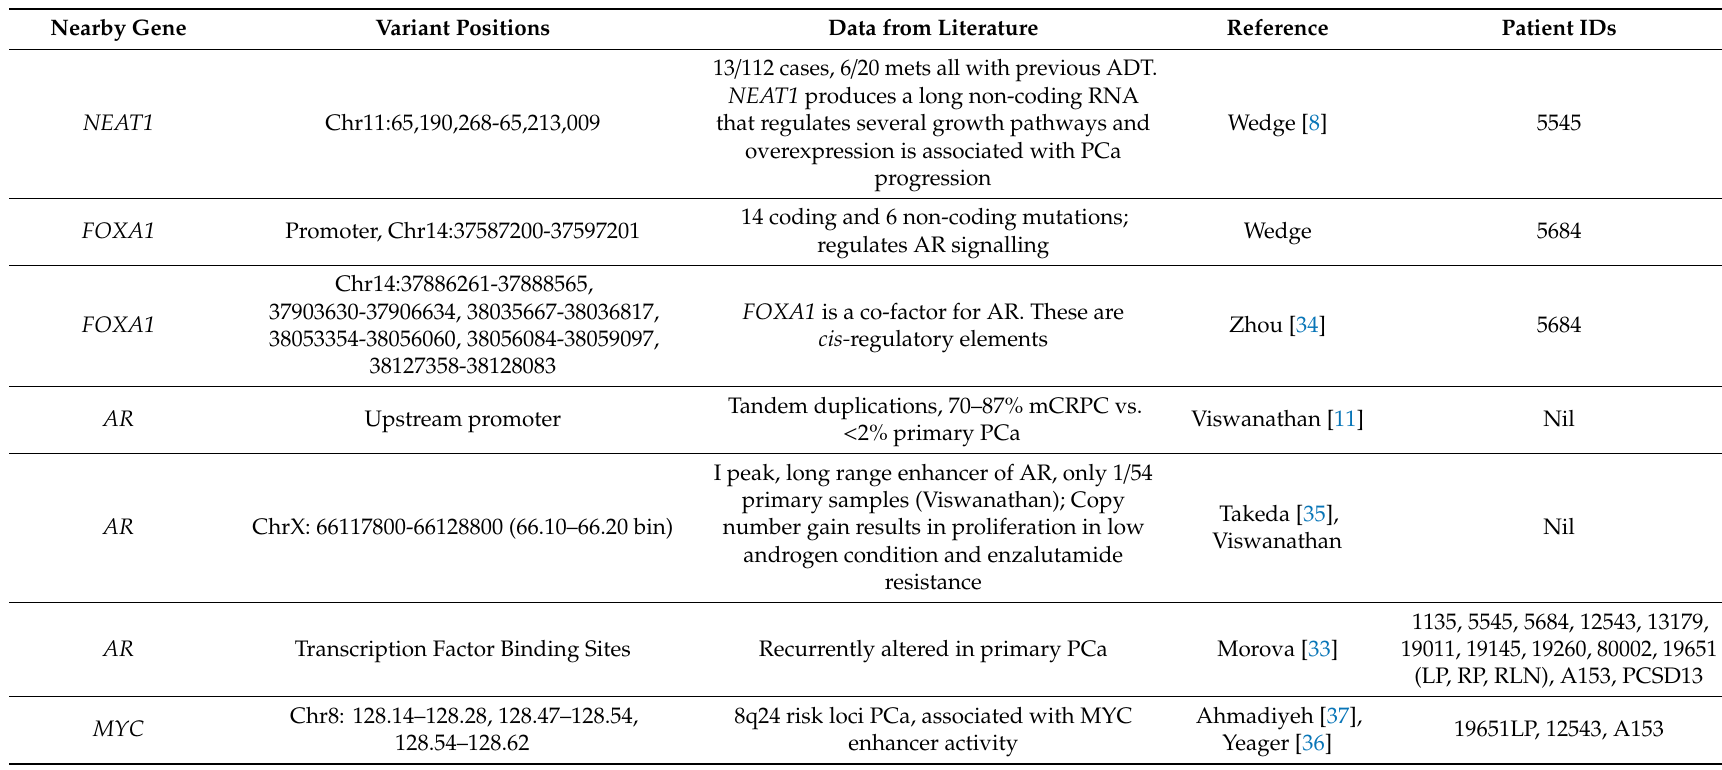
Table 4. Sites of recurrent non-coding alterations reported in the literature with potential clinical